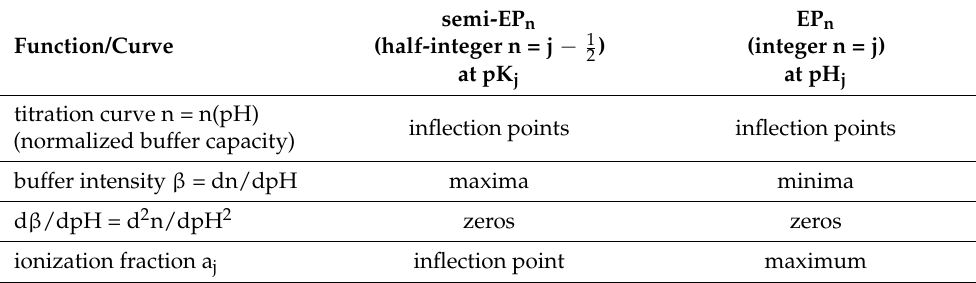
Table 7. Equivalence points as local extrema and inflection